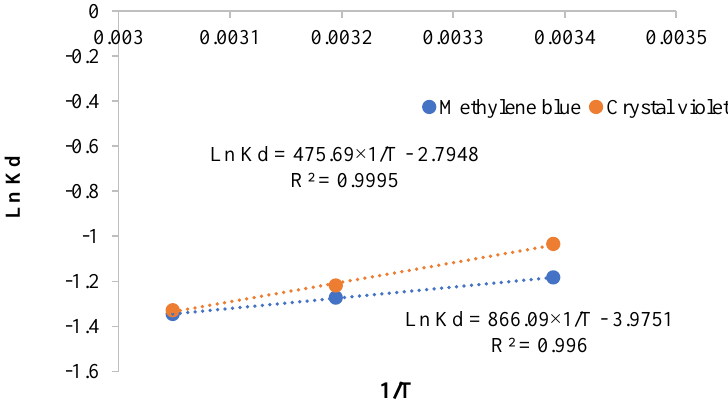
Ln Kd = 866.09×1/T - 3.9751 R² = 0.996 Figure 12. Change of Ln Kd versus 1/T for methylene blue and crystal Figure 12. Change of Ln Kd versus 1/T for methylene blue and crystal violet. Figure 12. Change of Ln Kd versus 1/T for methylene blue and crystal violet.